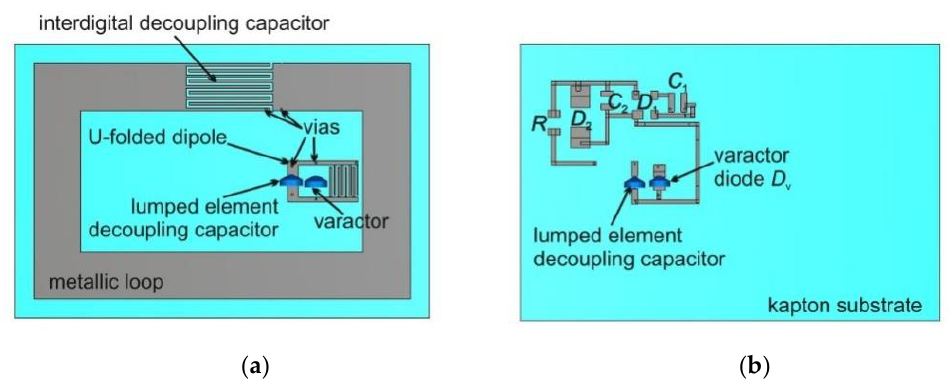
Figure 5. Layout of the proposed RFID chipless sensor tag: ( a ) top layer with U-folded dipole and metallic loop; ( b ) bottom layer with rectifying circuit. Blue—dielectric kapton substrate; grey—copper layer.